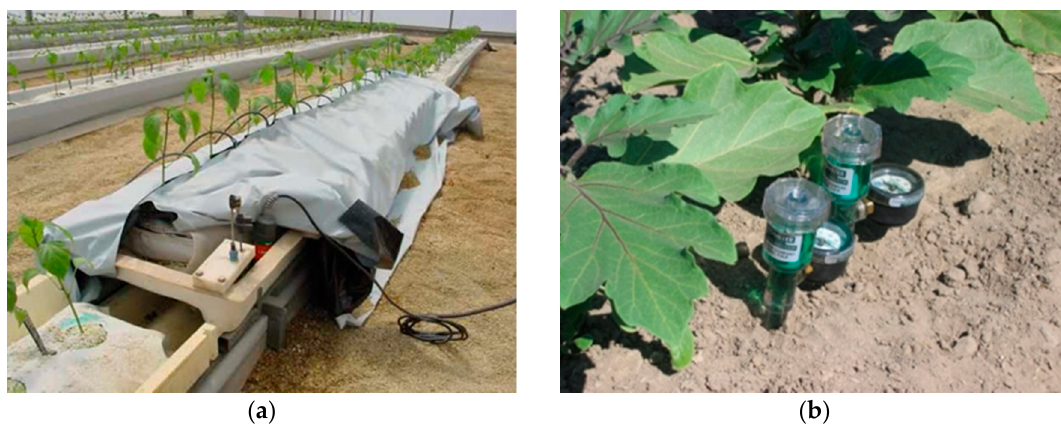
Water 2017 , 9 , 785